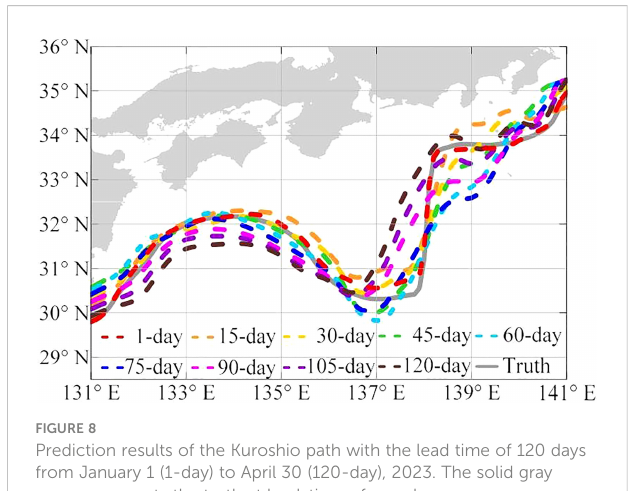
FIGURE 8 Prediction results of the Kuroshio path with the lead time of 120 days from January 1 (1-day) to April 30 (120-day), 2023. The solid gray curve represents the truth at lead-time of one